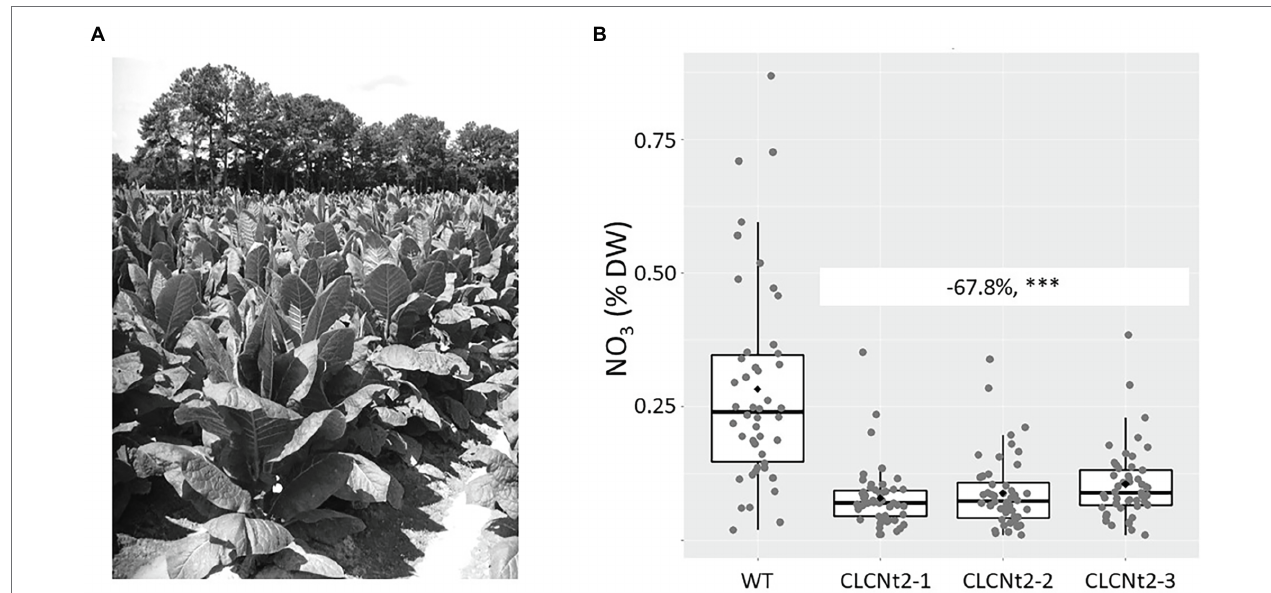
FIGURE 3 | (A) Field view of the CLCNt2 -RNAi (CLC2-1, CLC2-2, and CLC2-3) and wildtype (WT) plant lines grown in a random design. All plant materials of each genotype were pooled from the same field location (between 39 and 47 viable plants per genotype). (B) Average nitrate content (%DW) in cured leaf lamina of the